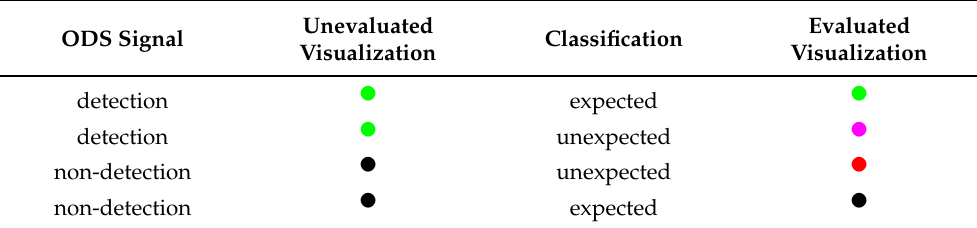
Table 7. Tabular overview of the evaluated and unevaluated visualization of the expected and unexpected detection and non-detections.